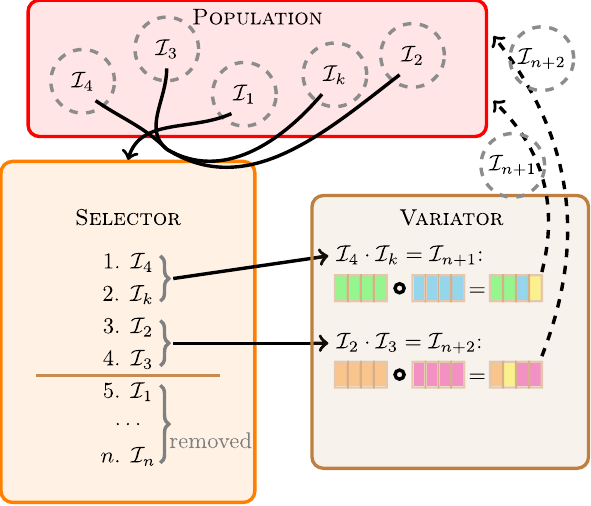
FIG. 2. Schematic view of interplay between selector and variator. The selector ranks all individuals in the population according to fitness and subsequently the variator uses the fittest individuals to produce new offspring. Finally, the new children are reintroduced in the